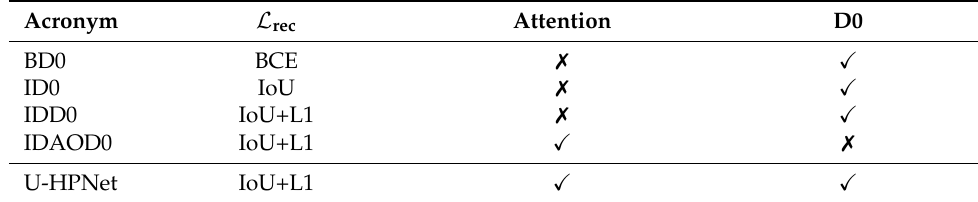
Table 3. Different network setups of the U-HPNet configured in the ablation study.